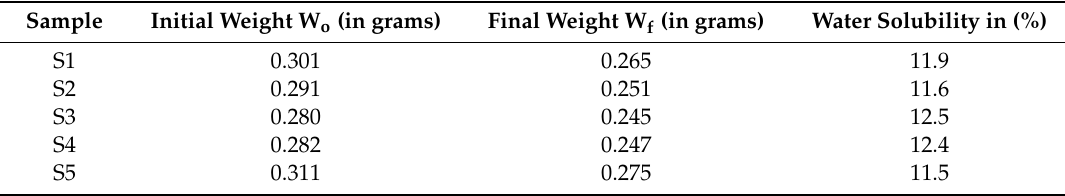
Table 6. Water solubility of bioplastics.